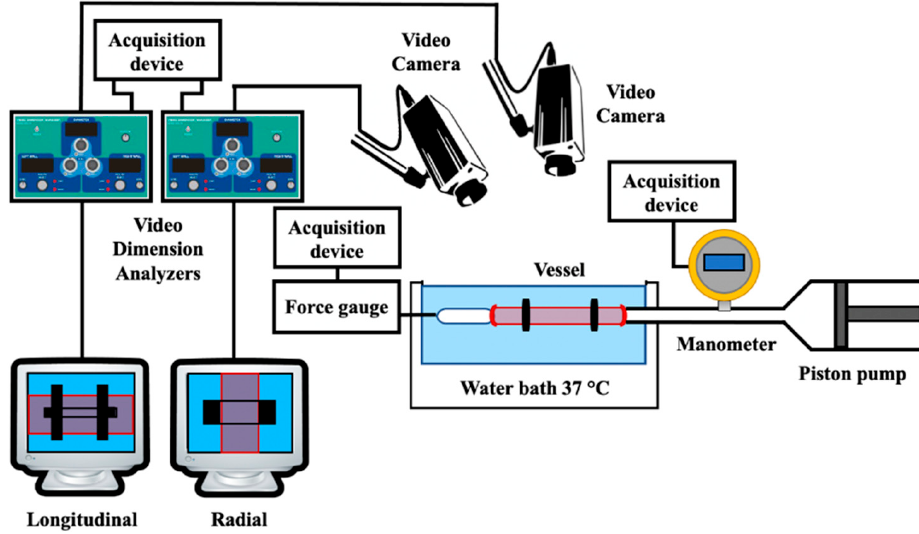
Figure 5. Example of experimental set-up for the study of device testing in [73].